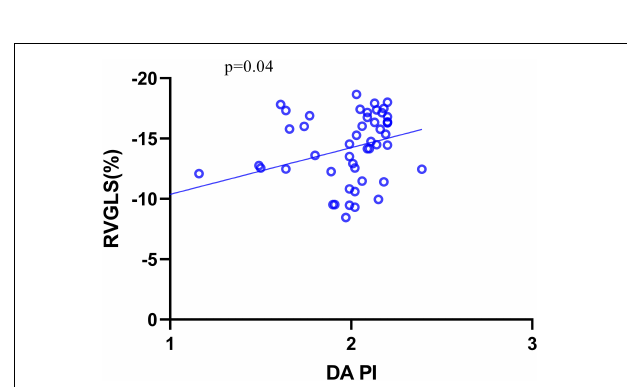
FIGURE 4 | The relationship between RVGLS and DA PI. GLS, global longitudinal strain; PI, pulsatility index.